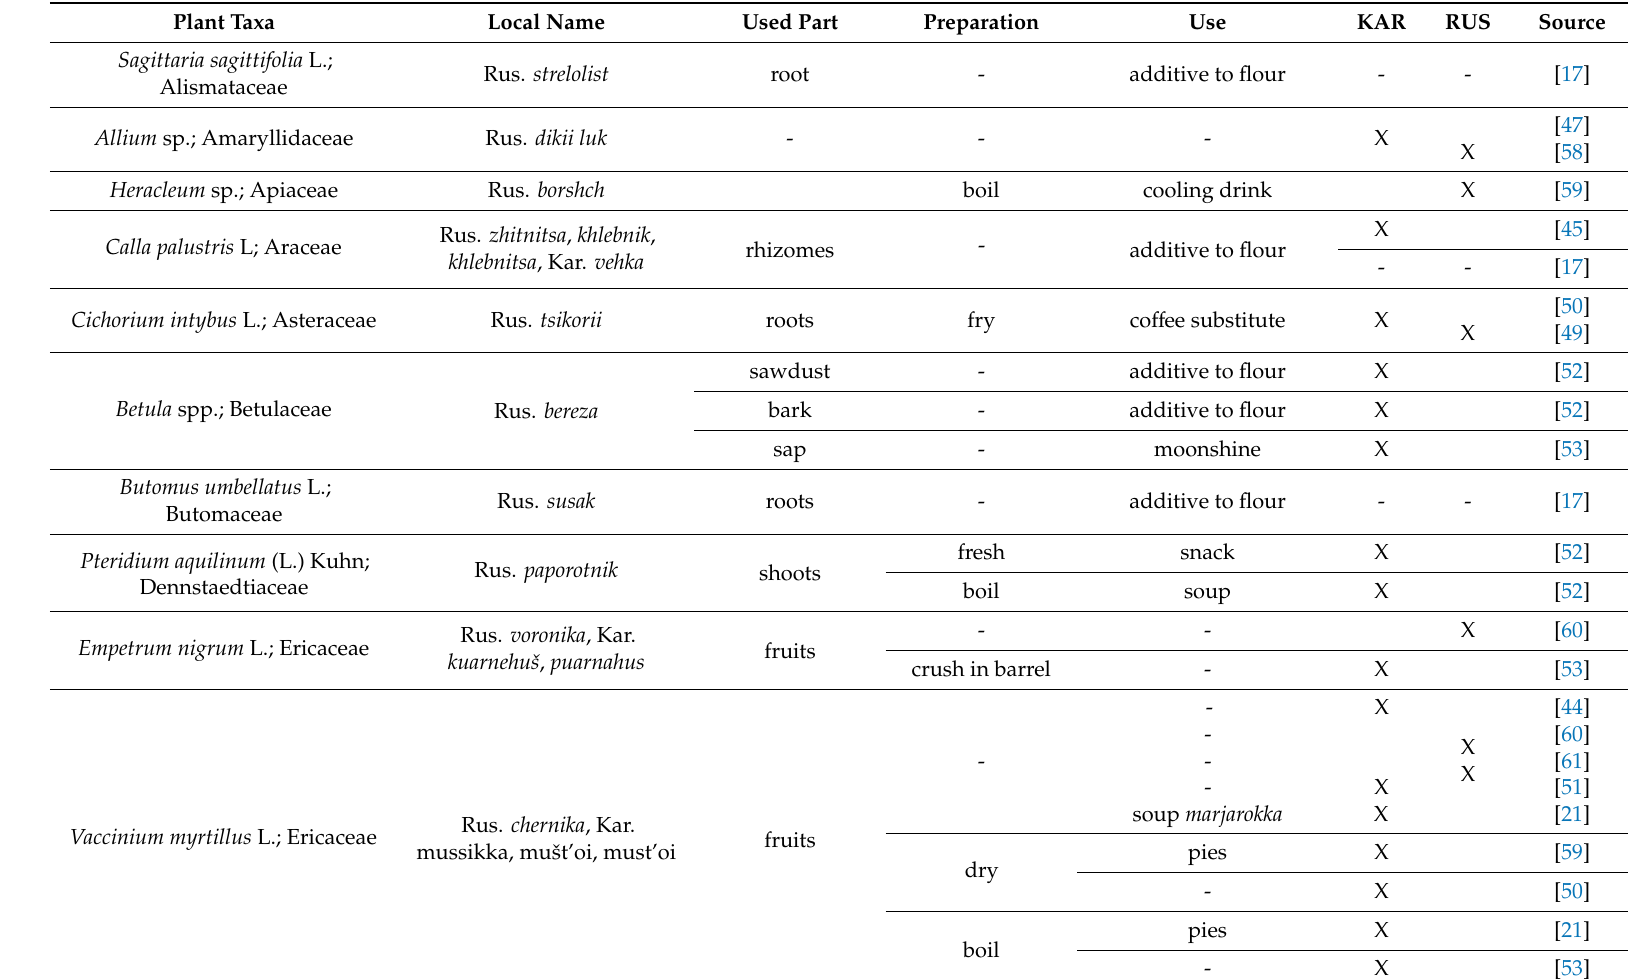
Table 3. Historical uses of wild plants in